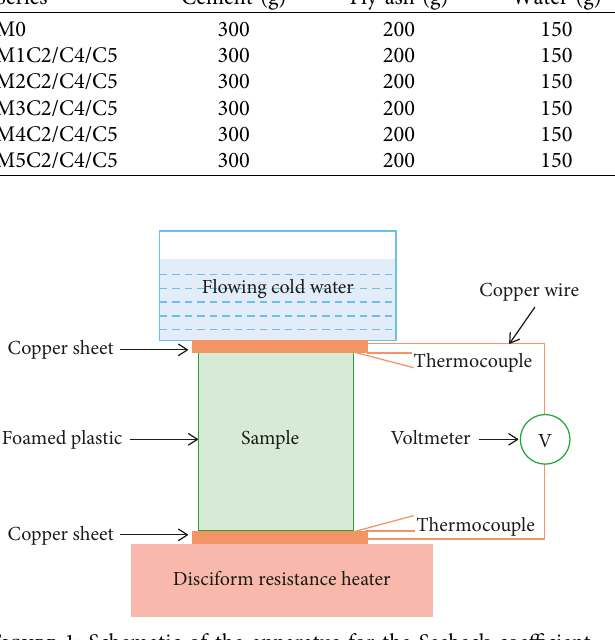
Figure 1: Schematic of the apparatus for the Seebeck coefficient measurement.